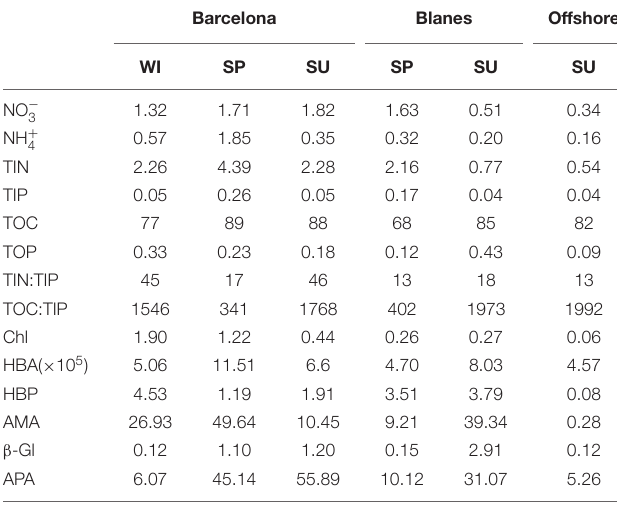
heterotrophic bacterial abundance (HBA; cell ml − 1 ), heterotrophic bacterial production (HBP; µ g C l − 1 d − 1 ), and enzymatic activities (nmol l − 1 h − 1 ) measured at the beginning of the six experiments.